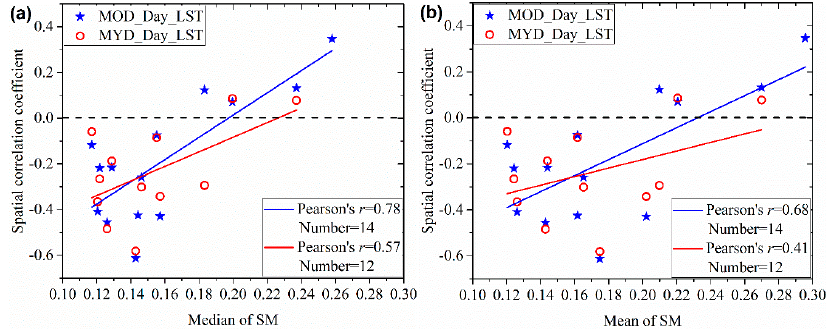
Figure 8. Comparing ( a ) Median and ( b ) Mean of SM over the study area with the spatial correlation coefficient between daytime LST and SM. MOD_Day_LST and MYD_Day_LST are the daytime LSTs from Terra and Aqua MODIS sensors, respectively. Pearson’s r is the Pearson correlation coefficient and Number is the number of samples.